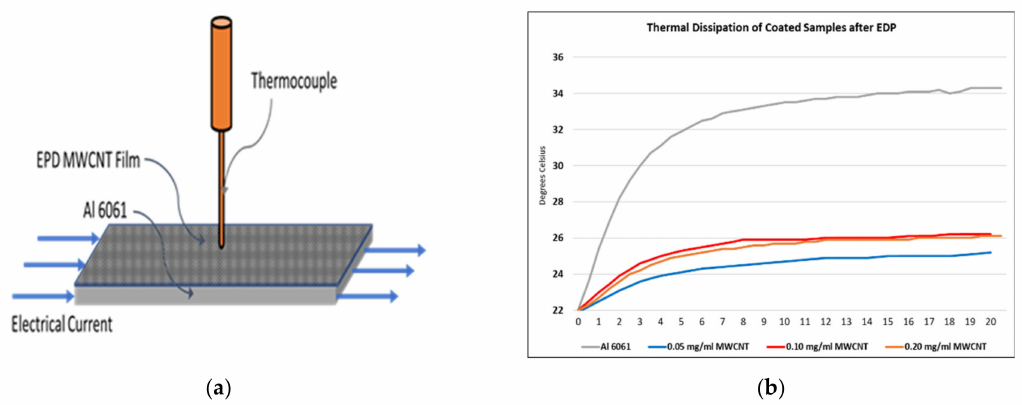
Figure 7. ( a ) Schematic diagram of the thermal dissipation experiment. ( b ) The uncoated samples of Al6061 exhibit a temperature rise of 34 ◦ C, while those coated with MWCNTs concentration solutions of 0.05, 0.10 and 0.20 mg / mL exhibit an average maximum temperature rise of 26, 27.66 and 28.6 ◦ C, respectively. These values represent a surface thermal dissipation improvement, respectively, of 31%, 24% and 19%, when compared to the uncoated material aluminum